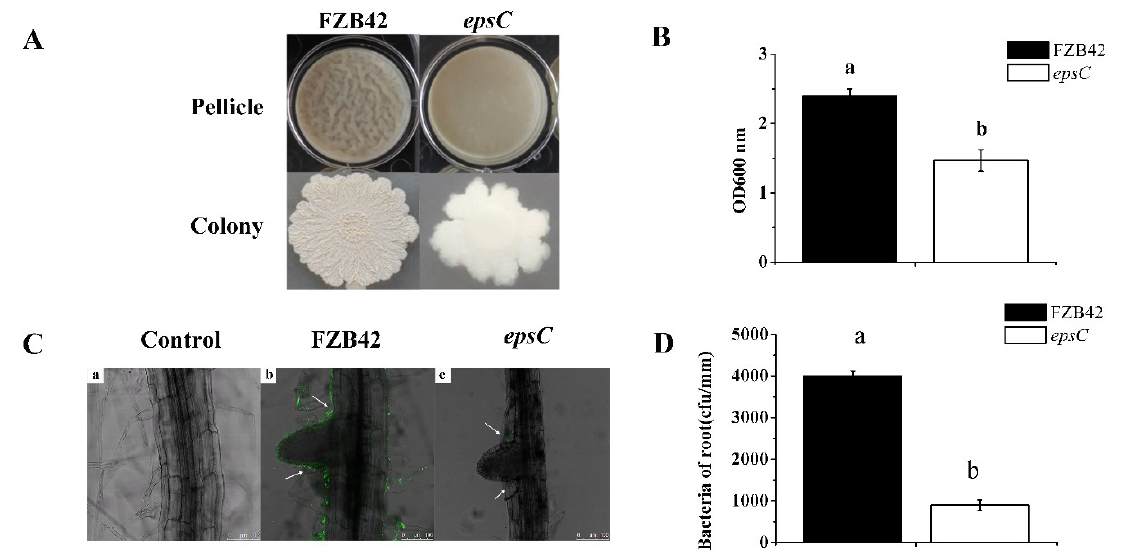
Figure 6. Biofilm formation by wild type FZB42 and the epsC mutant. The upper panel illustrates the formation of a pellicle by cells cultured at 30 °C for three days on LBGM medium (Lysogeny broth supplemented with 1% ( v / v ) glycerol and 0.1 mM MnSO 4 ); the lower panel illustrates colony morphology ( A ), quantitative spectrophotometric assay of biofilms stained with crystal violet ( B ), confocal laser scanning microscopy analysis of root colonization. Scale bar, 100 μm ( C ), adherence capacities of wild type and epsC mutant to the A. thaliana root ( D ). Values in ( B ) and ( D ) are shown as means, with the whiskers representing the standard error (SE, n = 12). Different letters above each column indicate statistically significant ( p < 0.05) differences in mean performance.